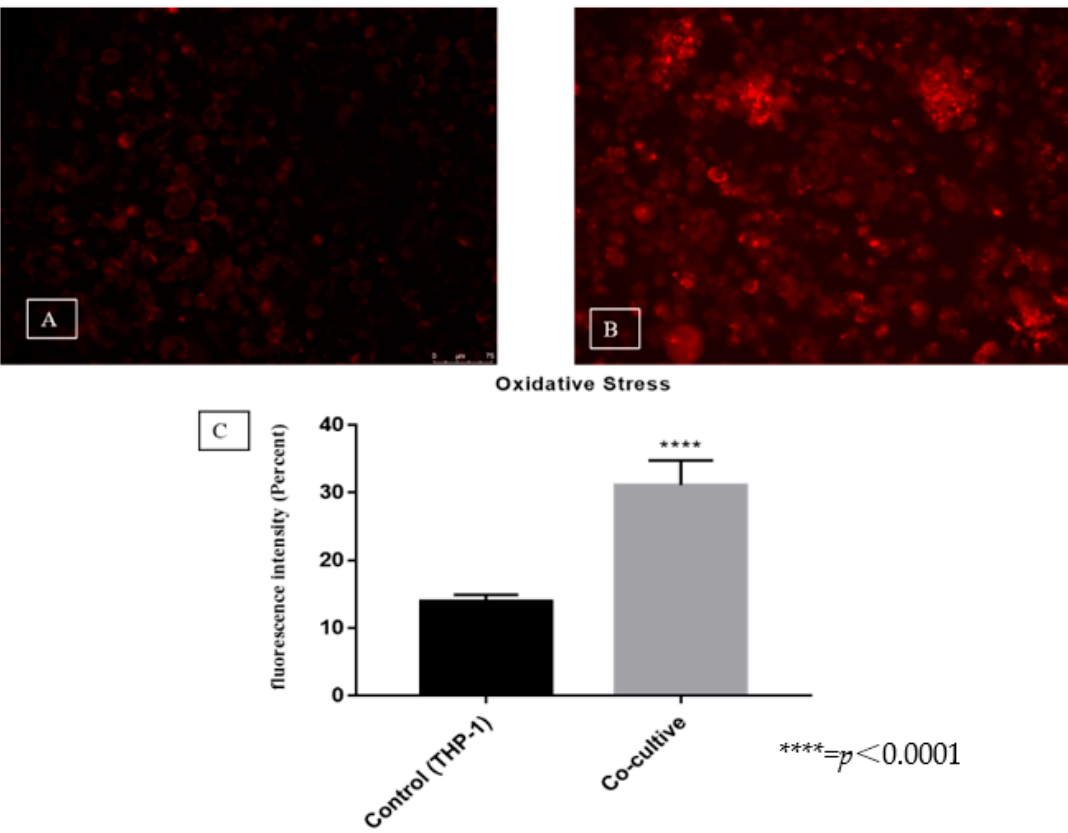
Figure 4. Representative photomicrograph of fluorescence intensity in the control ( A ) and co-culture ( B ). Quantification of fluorescence intensity ( C ).